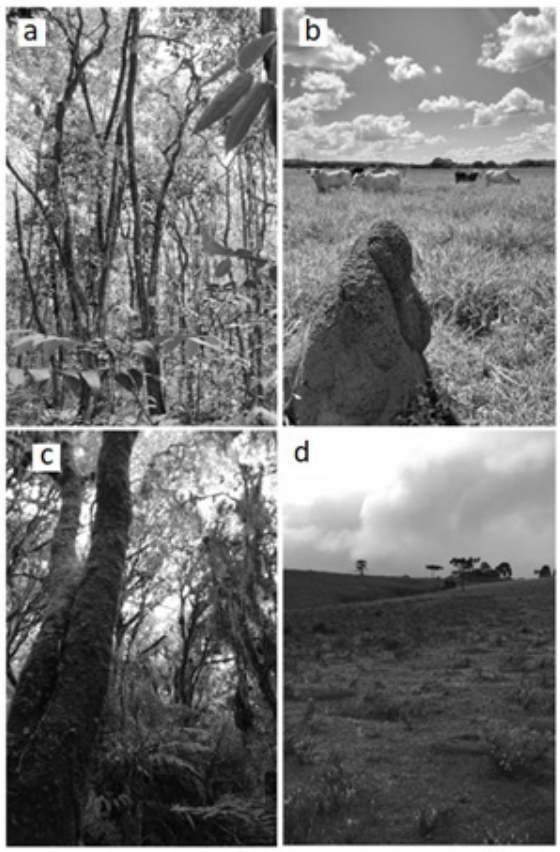
Figure 2. View of the sites. Savanna Tall Woodland – Cerradão (a) and pasture with a termite mound (b) in Cerrrado biome, Planaltina, Federal District. Upper Montane Atlantic Forest (c) and grassland (d) in Atlantic Forest biome, Urupema, Santa Catarina